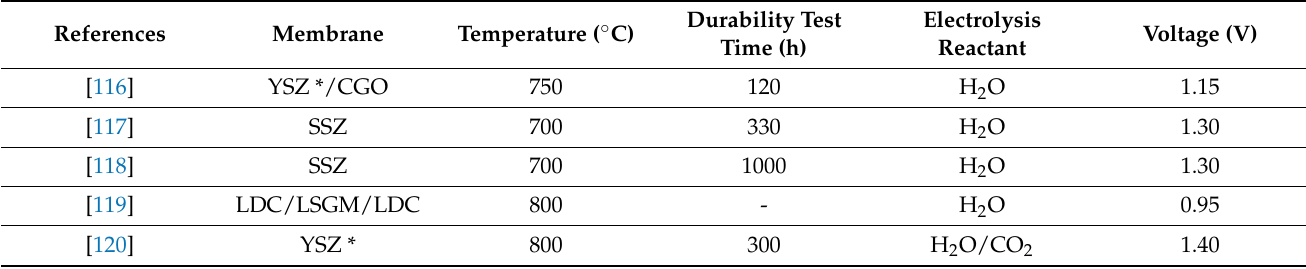
Table 3. Summary of SOE system for hydrogen production.